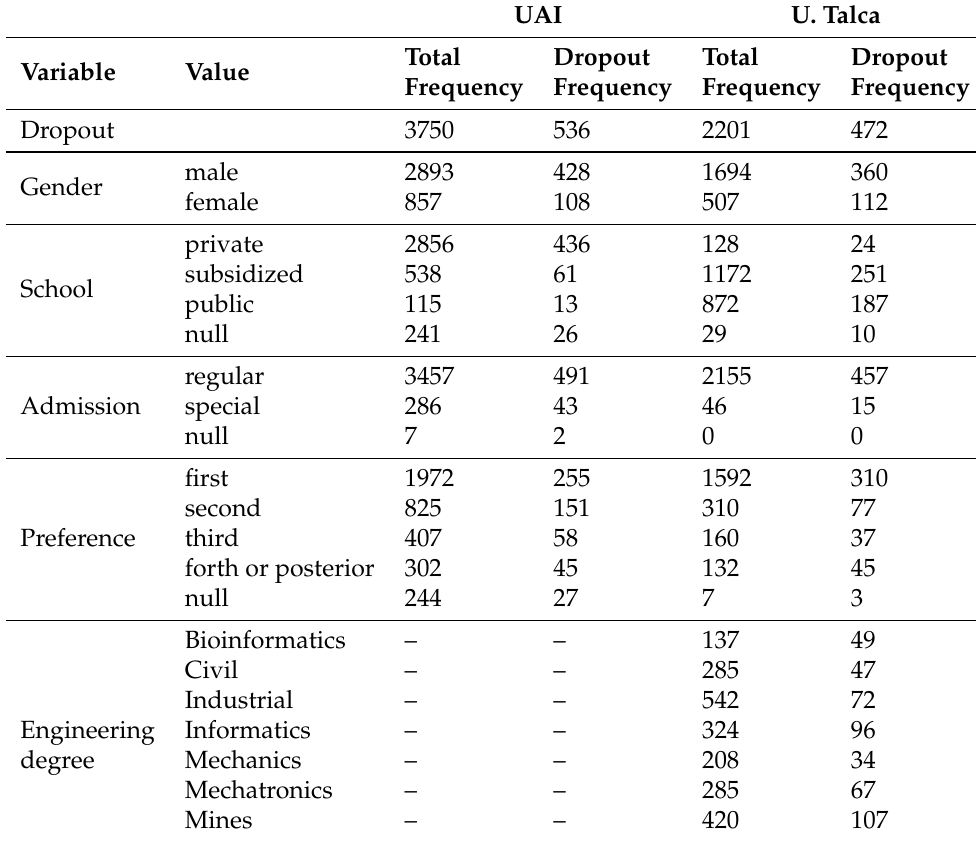
Table A1. Description of categorical